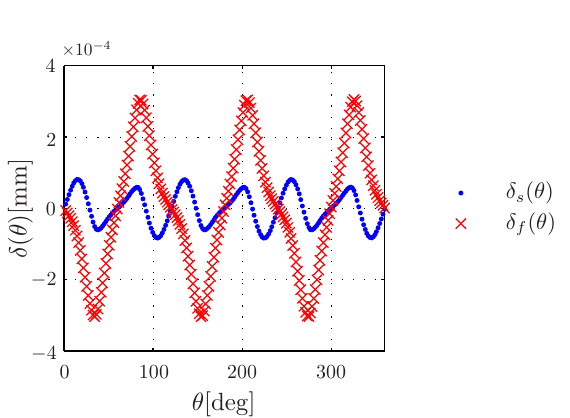
Figure 7: Axial deformation as function of y PLC - z PLC coordinates. The deflection pattern of the stiff model is δ s and the deflection pattern of the flexible model is δ f .